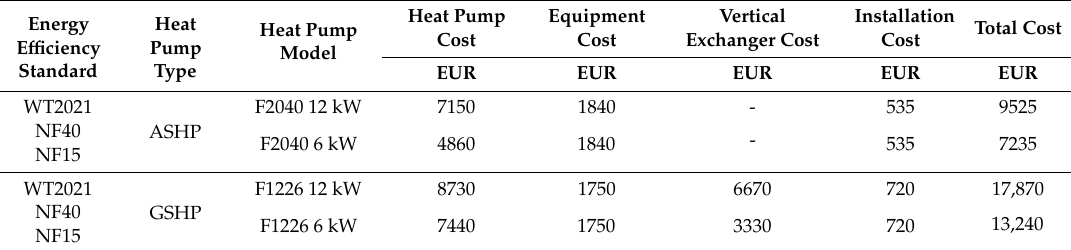
Table 17. The heating and DHW system cost.